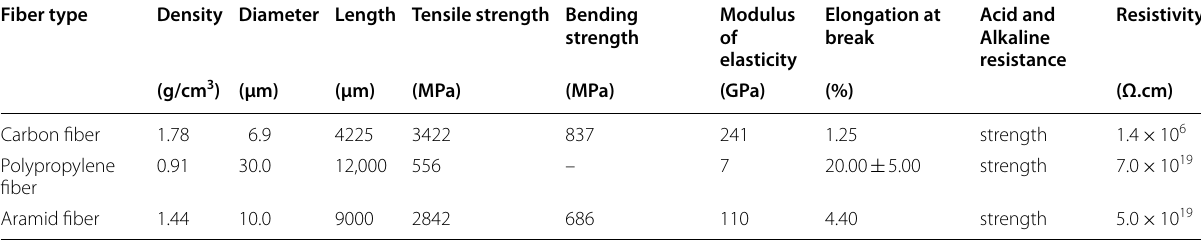
Table 2 Performance index of carbon, polypropylene and aramid fiber.